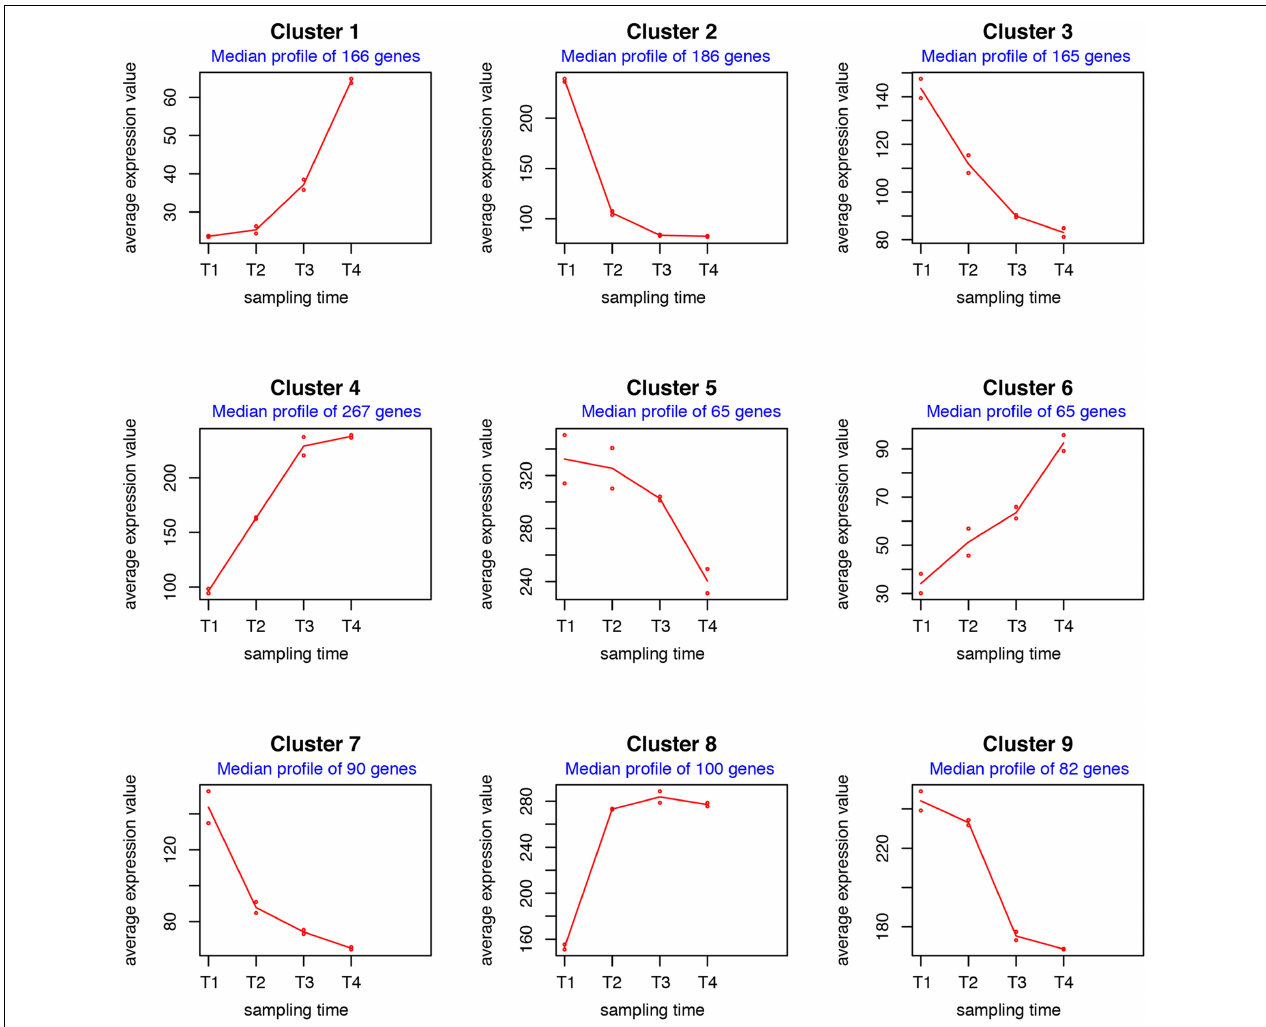
FIGURE 2 | maSigPro analysis of RNA-Seq time series dataset. The median profile of each cluster was inferred from the expression patterns shown in Supplementary Data Sheet 7 and Figure